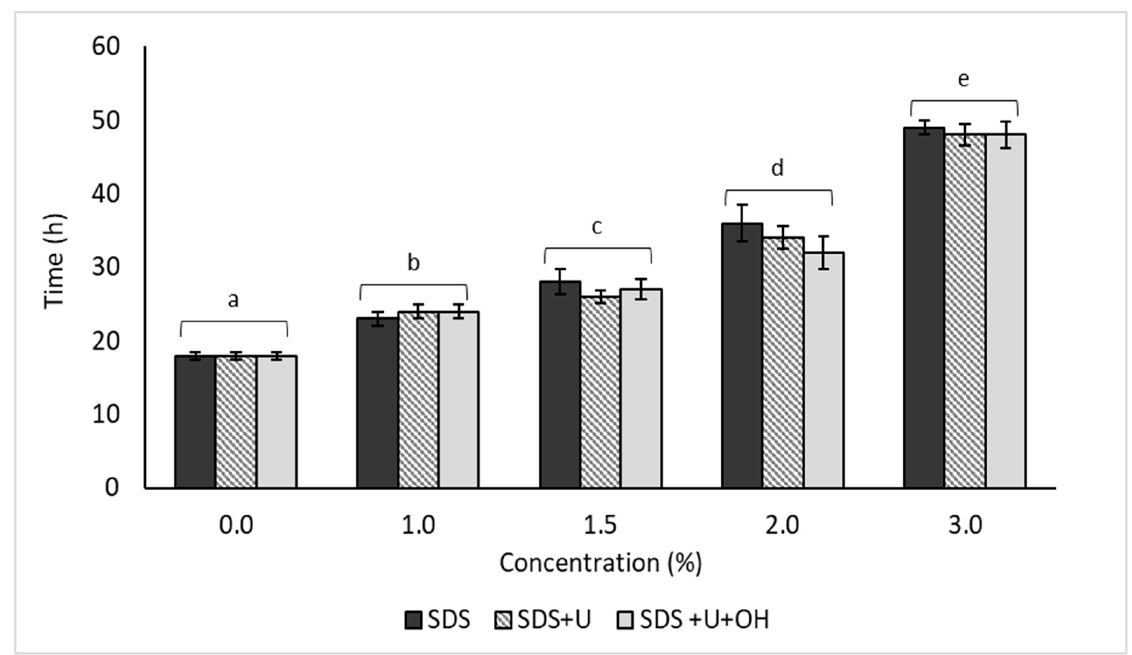
Figure 10. Coagulation of protein-reduced systems, equal letters correspond to statistically homogeneous groups using the LSD multiple range test.